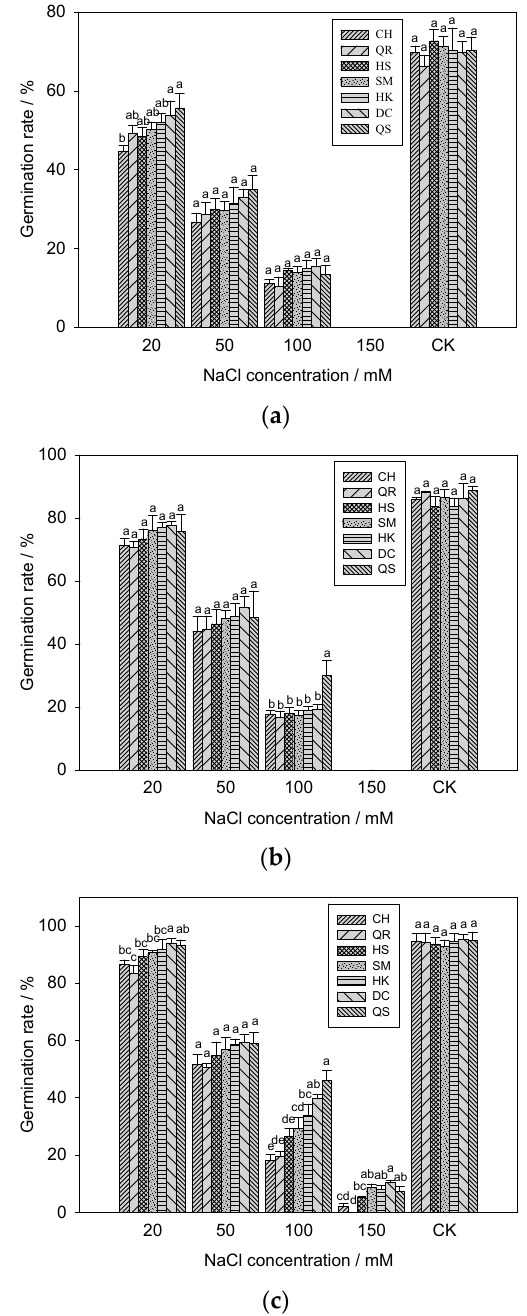
Figure 1. The germination rate (%) of the seven E. crus ‐ galli populations at different time points under salinity stress. The germination rate (%) of E. crus ‐ galli under four NaCl concentrations at ( a ) 48 h, ( b ) 72 h and ( c ) 96 h after treatment. CH, the E. crus ‐ galli biotype collected from Chunhua, Hunan province, China; QR, the E. crus ‐ galli biotype collected from Chunhua, Hunan province, China, which were bred for four generations from 2014 to 2017, and resistant to quinclorac; HS, the E. crus ‐ galli biotype collected from Hanshou, Hunan province, China; SM, the E. crus ‐ galli biotype collected from Shimen, Hunan province, China; HK, the E. crus ‐ galli biotype collected from Hekou, Hunan province, China; DC, the E. crus ‐ galli biotype collected from Dingcheng, Hunan province, China; QS, the E. crus ‐ galli biotype collected from Chunhua, Hunan province, China, which were bred for four generations from 2014 to 2017, and sensitive to quinclorac. The same as below. Lowercase letters are expressed as least square means ± standard error ( p < 0.05).